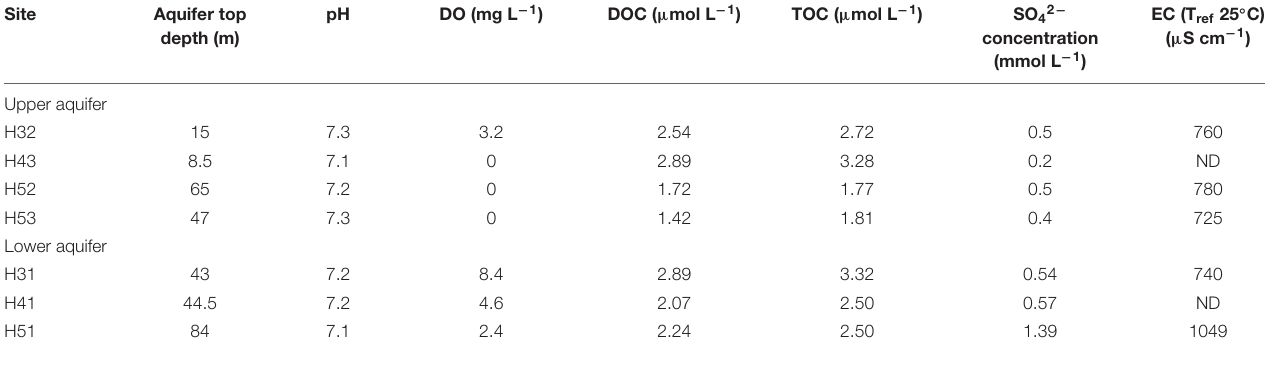
TABLE 1 | Physiochemical parameters of groundwater samples from the upper and lower aquifers; sampling campaign September 2013.